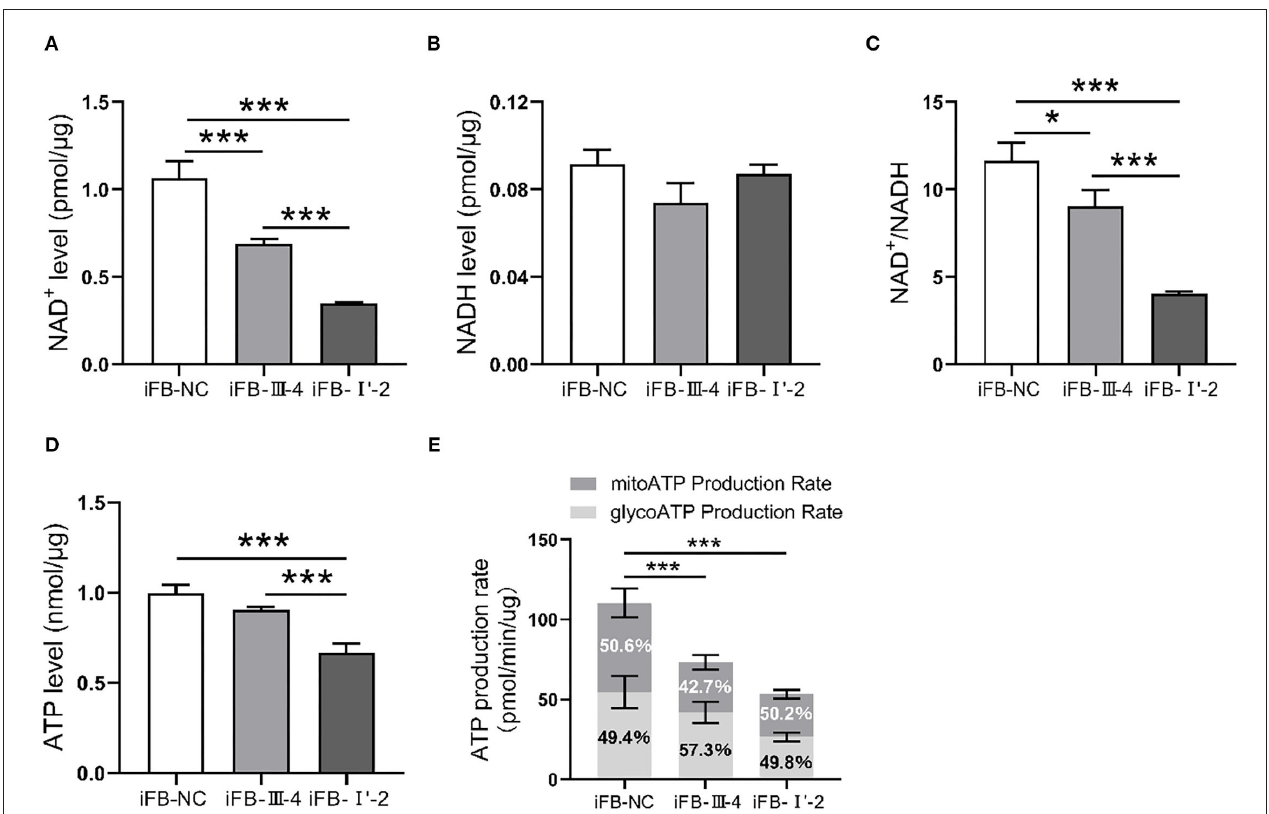
FIGURE 4 | The iFB-LHON cells with more variants have lower energy synthesis capacity. (A,B) NAD + and NADH level in mitochondria were tested in fibroblast cells. *** p ≤ 0.001. (C) The ratio of NAD + /NADH was calculated. * p ≤ 0.05, *** p ≤ 0.001. (D) Fibroblast cells were collected and ATP level in mitochondria was examined in both cells. *** p ≤ 0.001. (E) ATP production rates in fibroblast cells were detected by seahorse XF96 analysis. The mitoATP production rate refers to the ATP production rate related to mitochondrial oxidative phosphorylation (expressed as pmol ATP/min). The glycoATP production rate associated with the conversion of glucose to lactic acid in the glycolysis pathway (also expressed as pmol ATP/min). *** p ≤